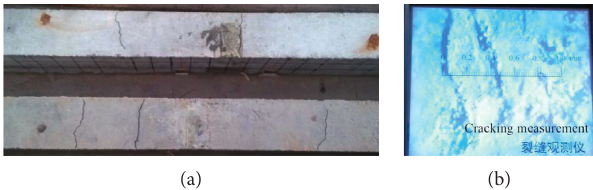
Figure 4: Detecting of the appearance and cracks. (a) Appearance and cracks of beam. (b) Cracks.